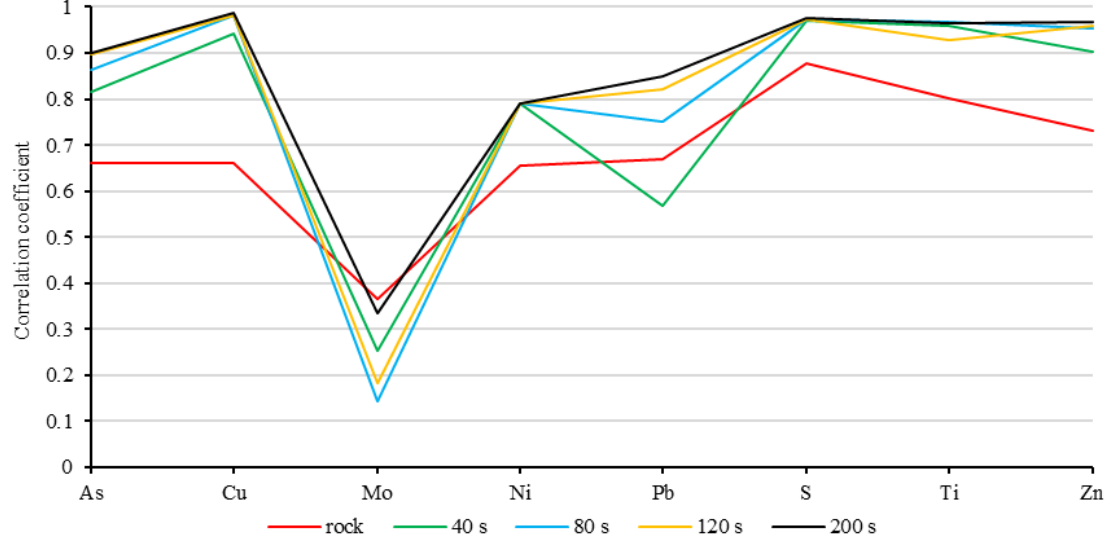
Figure 5. Similarity between the analysis results of pXRF and laboratory. The 40 s, 80 s, 120 s, and 200 s are the results of rock powder samples reported by pXRF.